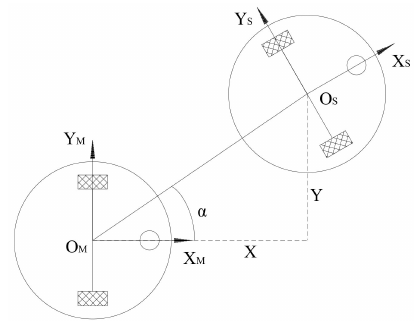
Figure 1. Robot modeling and different